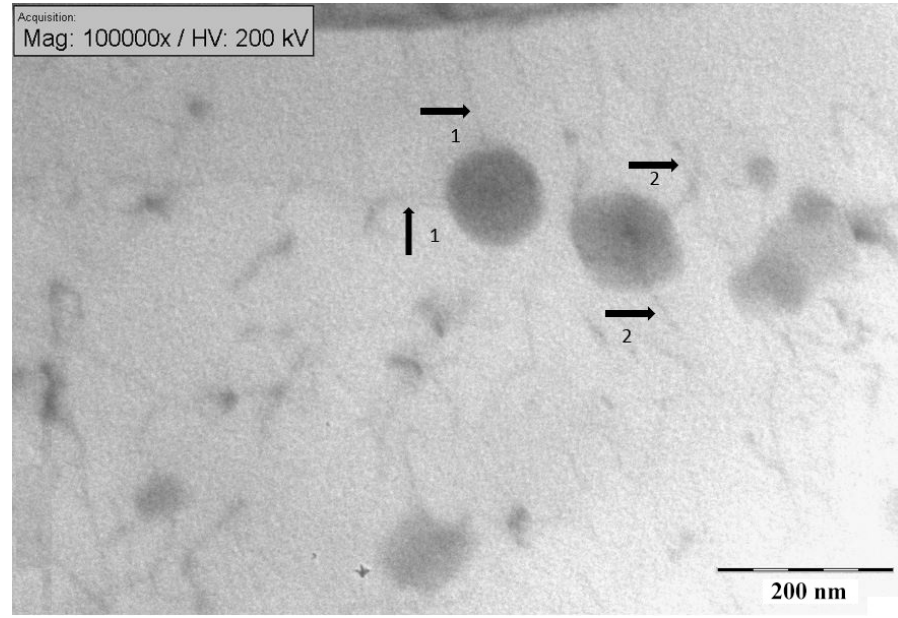
Figure 7. TEM photo shows the intersection of dislocation 1 ‐ 1 and 2 ‐ 2 with two fine precipitates in the matrix of CFT6a sample, respectively.